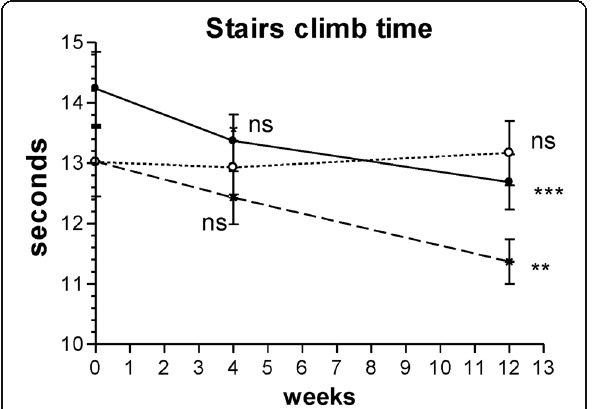
Fig. 3 The changes with time in a fast-paced walking test timed over 4×10 m for a total 40 m at weeks 0, 4, and 12 in the Curamin, CuraMed and placebo treatment groups. Within-group improvements (* p <0.05, ** p <0.01, *** p <0.001) in physical performance tests at the end of the study (visit 3) compared to baseline (week 0)